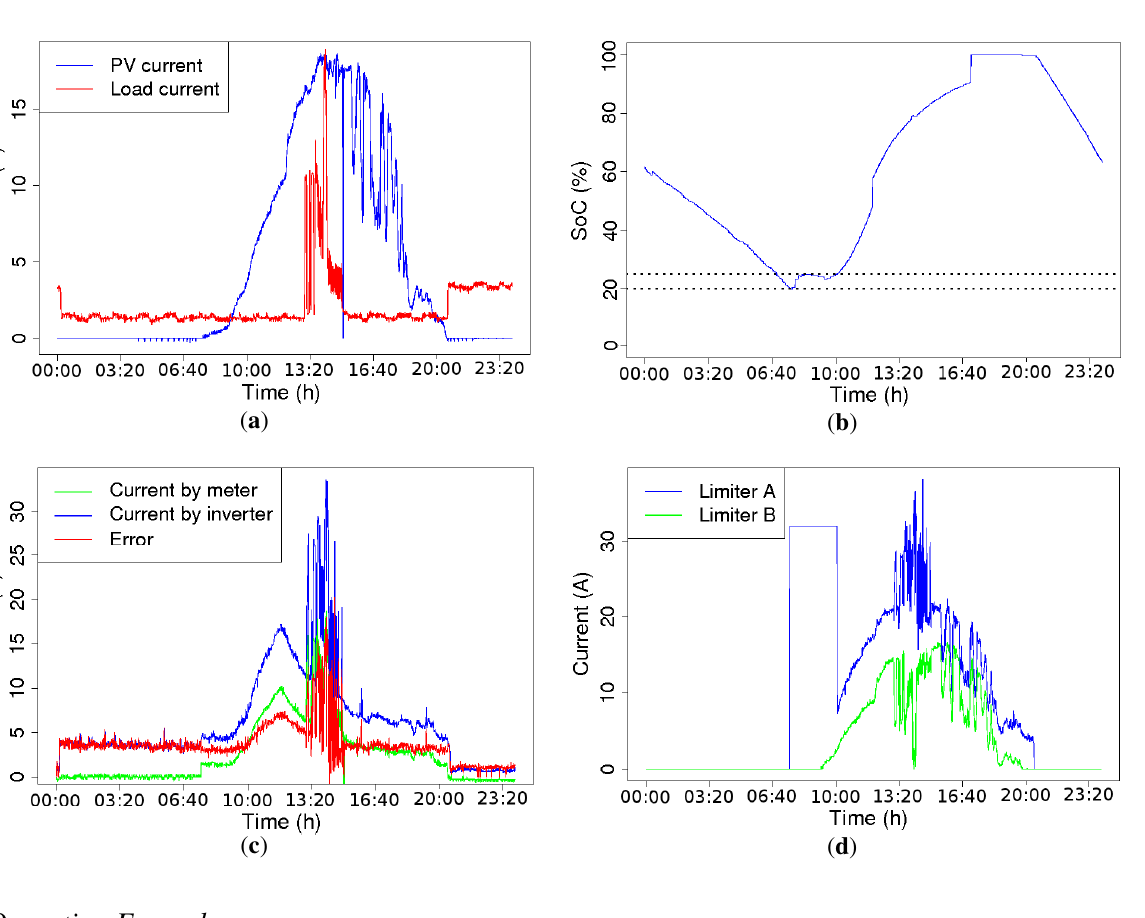
Figure 5. Battery controller example: ( a ) PV and Load current; ( b ) SoC; ( c ) current error of limiter A; and ( d ) current